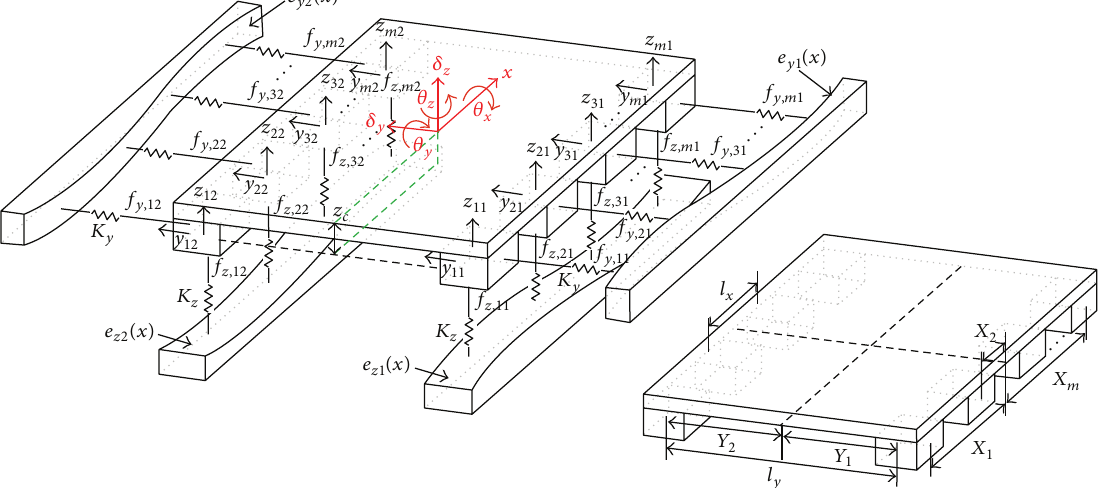
Figure 9: Analytic model for estimating 5-DOF motion errors.